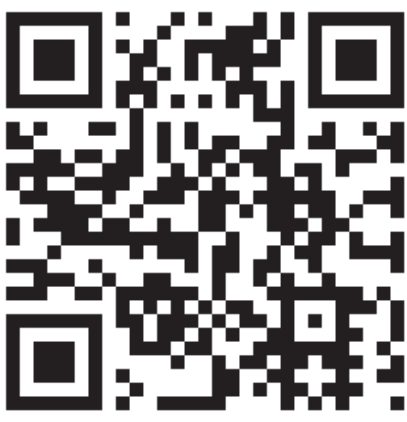
Figure 10: YouTube link [15]: task grafting with changing road condition information.